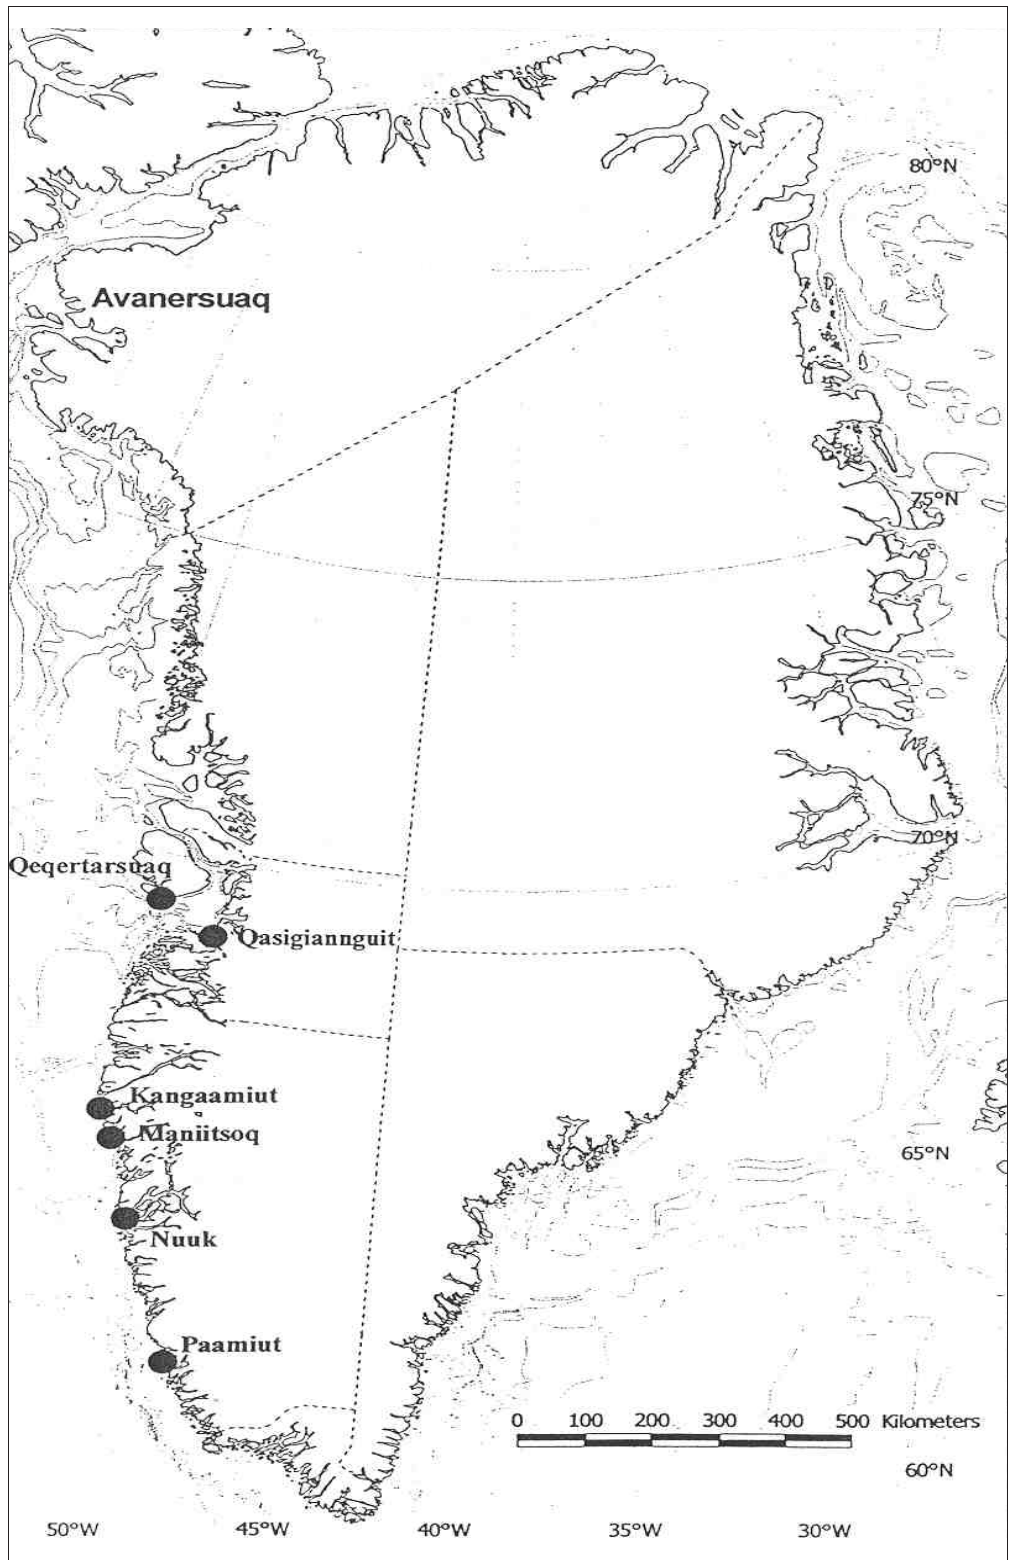
Fig. 2. Map of Greenland showing sites mentioned in the